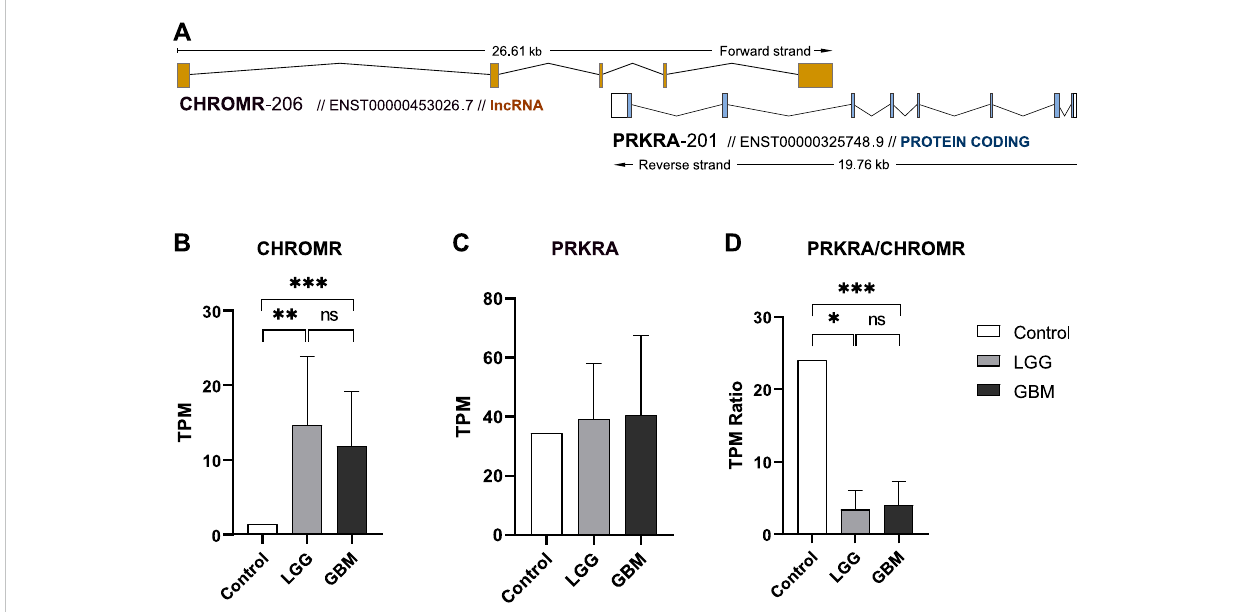
FIGURE 1 ncNAT CHROMR and its overlapped protein coding gene PRKRA expression in glioma and normal brain tissue. (A) Schematic view of lncRNA CHROMR-206 (ENST00000453026.7, + strand) and mRNA PRKRA-201 (ENST00000325748.9, — strand) transcript genomic overlap as annotated in Ensembl genome browser. Exons are depicted as colored boxes. (B – D) . Our in-house RNAseq data of healthy brain (control), LGG and GBM samples for lncRNA CHROMR (B) , mRNA PRKRA (C) genes and mRNA PRKRA/lncRNA CHROMR expression ratio (D) . N (Control, LGG, GBM) = 1; 7;